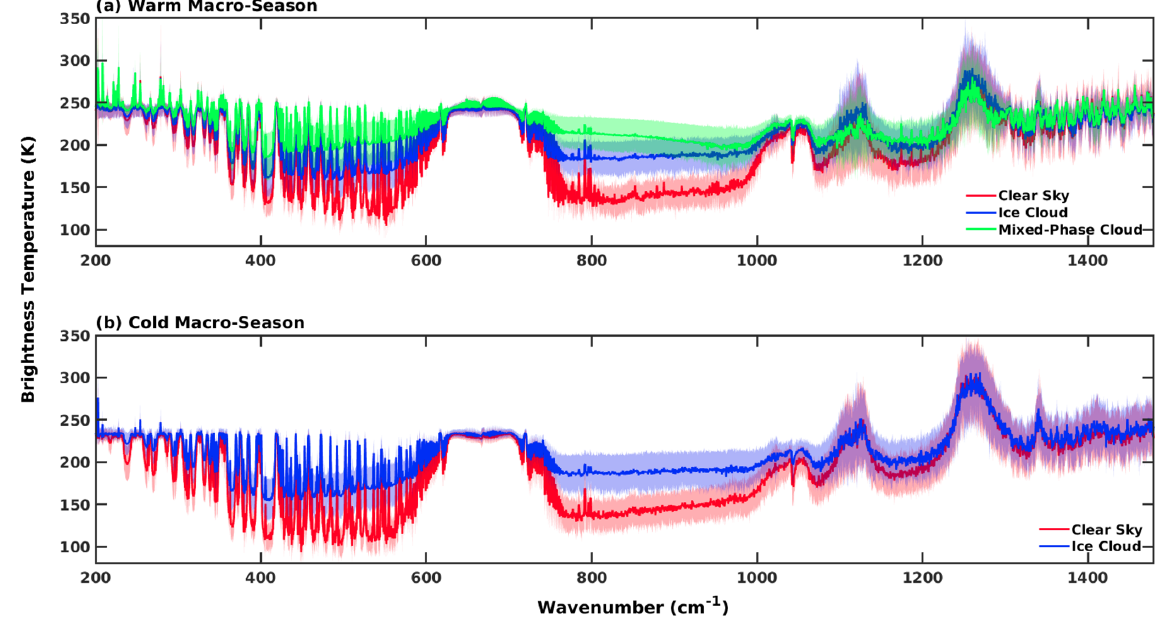
Figure 5. Average BT (solid line) ± 1 standard deviation (shaded area) for TS elements of the (a) warm and (b) cold macro-seasons.